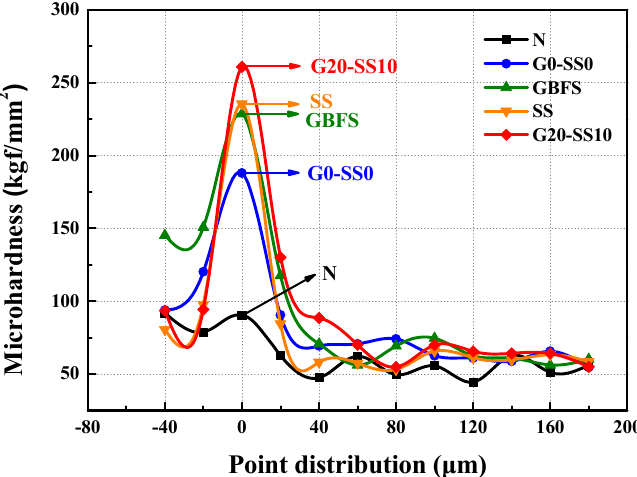
Figure 11. The microhardness of the ITZ of the concrete.